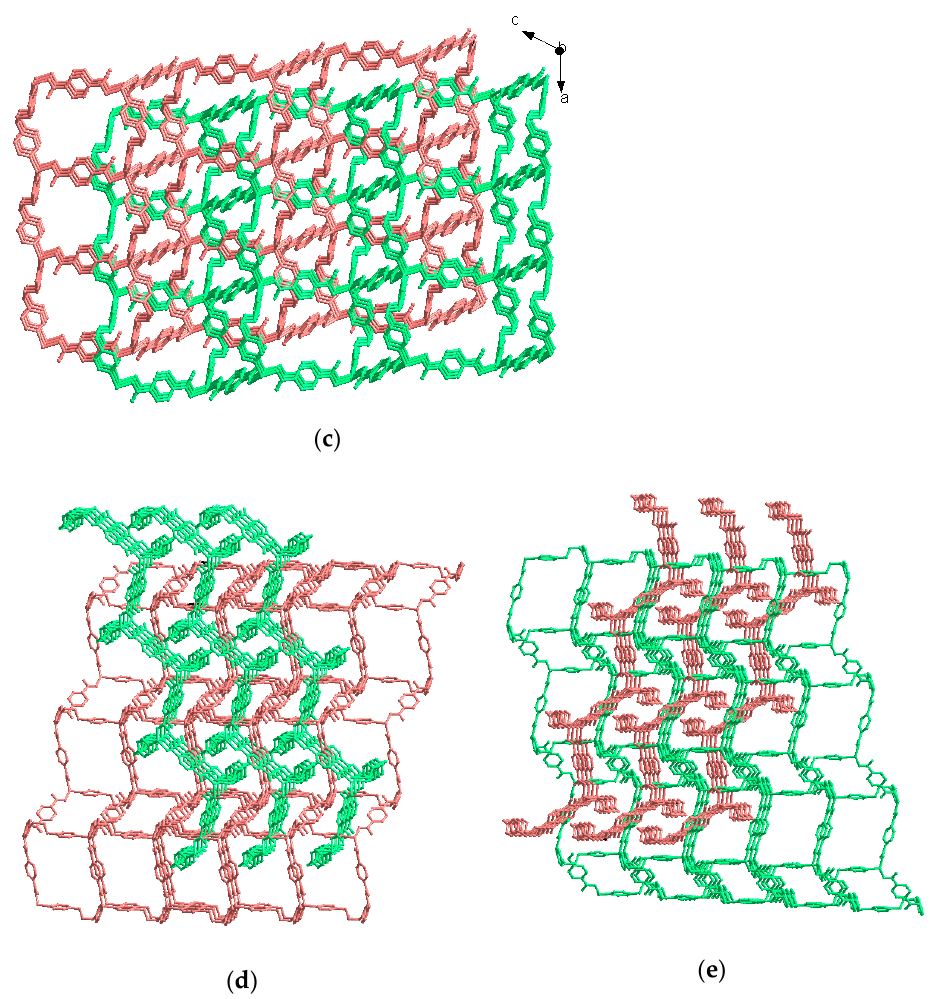
Figure 1. ( a ) Distorted tetrahedral geometry of Zn(II) ion in compound 1 with atom labeling scheme (30 % thermal ellipsoids); ( b ) the 2D layered metal–organic framework (MOF) (up) with undulated manner (down); ( c ) the 3D supramolecular network constructed by the mutually catenated between 2D undulated layered (MOFs); the 3D supramolecular network viewing ( d ) along the (1,1,0) direction and ( e ) along the (1, − 1,0) direction. Table 3. Structural parameters of O − H ··· O hydrogen bonds in compound 1 Table 1. Bond lengths (Å) and angles (°) around Zn(II) ion 1 .